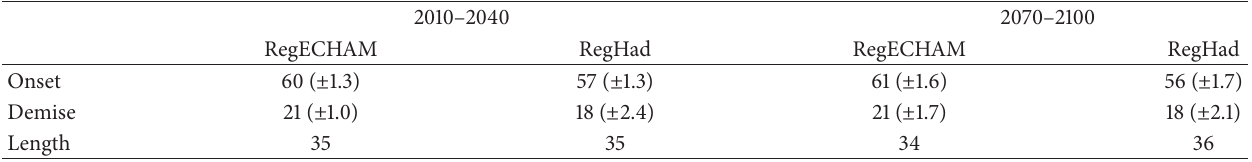
Table 2: Similar to Table 1 but in near- and far-future climates (mean and standard-deviation of the